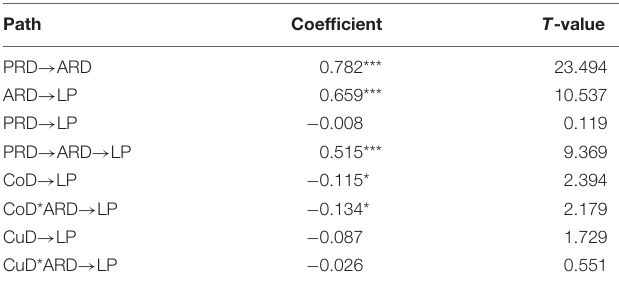
TABLE 2 | Test of moderating effect of cultural and cognitive differences in Learning Mechanism 2 ( N =